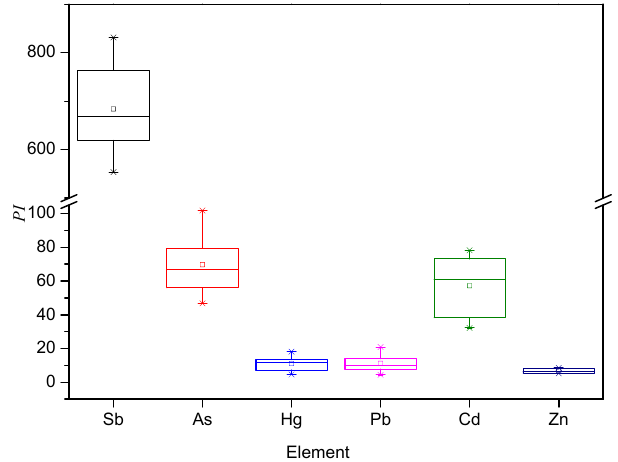
Figure 3. Box-plot of evaluating results by PI for dust.